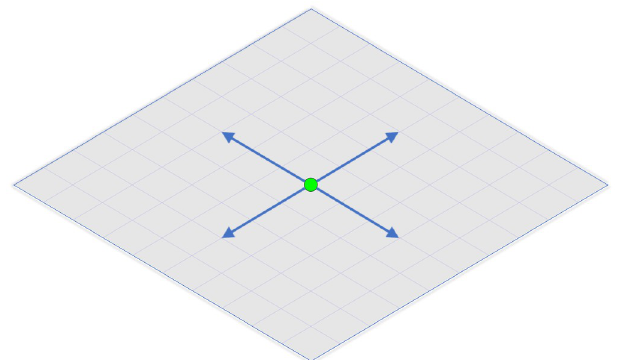
Fig 3. Virtual environment depiction. The participants location is represented by a green circle (target). This figure illustrates the layout of the virtual environment as displayed on the computer monitor, which requires the target to make a series of left and right turns. Once coming to a full stop, one of the two TMS coils will administer a single pulse over the participants occipital lobe depending on the programmed route (blue arrows). If participants respond correctly to the voice-automated questions that follow, the target will make a 90˚ turn in order to advance towards the next location. Perceiving all lateralized phosphene percepts allows the target to successfully